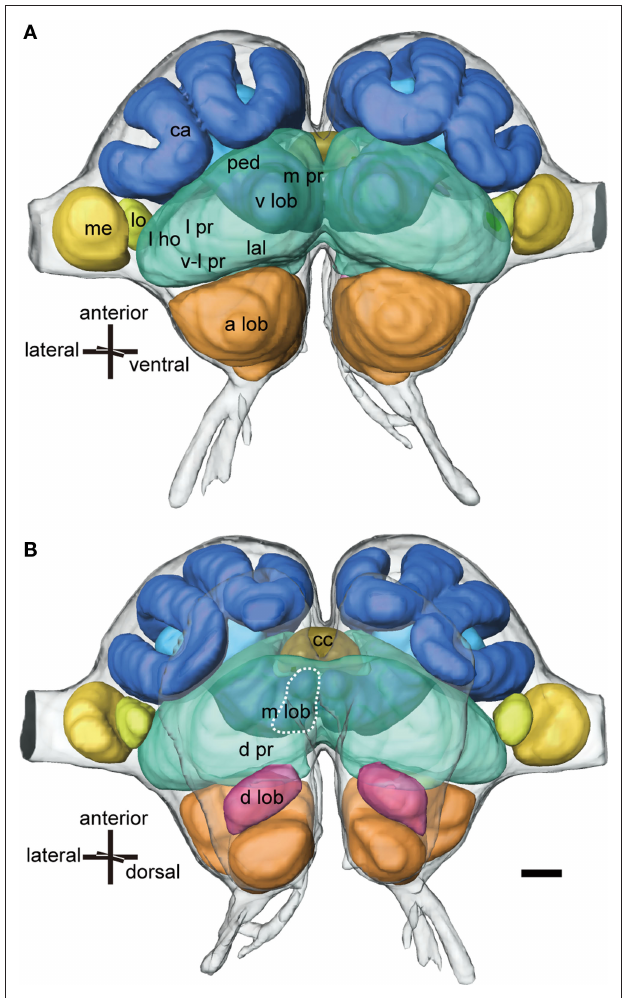
Figure 1 | Three-dimensional reconstructions of major neuropils of the ant brain viewed ventrally (A) and dorsally (B). The protocerebrum (green) consists of the mushroom body, the lateral PR (l pr) that includes the lateral horn (l ho), the ventro-lateral PR (v-l pr), the medial and dorsal PR (m pr and d pr), the lateral accessory lobe (lal) and the central complex (cc: khaki). The mushroom body consists of calyces (ca: blue), the pedunculus (ped: light blue) and the vertical and medial lobes (v lob, m lob: light blue, broken line). The medulla (med: yellow) and the lobula (lo: light yellow) are the second and third optic neuropils. The deutocerebrum consists of the antennal lobe (a lob: orange) and the dorsal lobe (d lob: magenta). Scale bar = 100 μm. Modified from Yamagata et al. (2007).